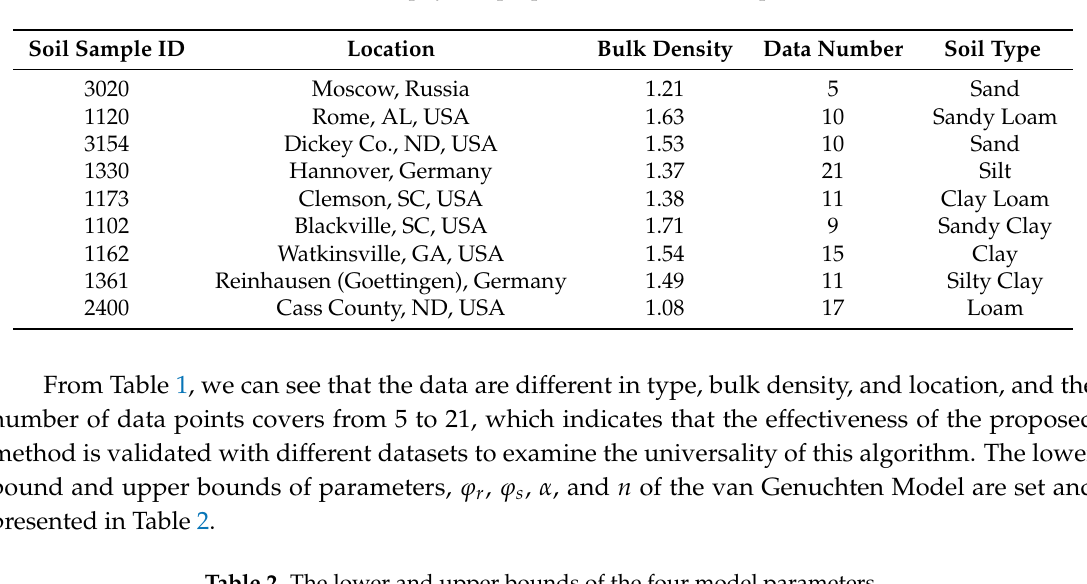
Table 1. The physical properties of nine soil samples.